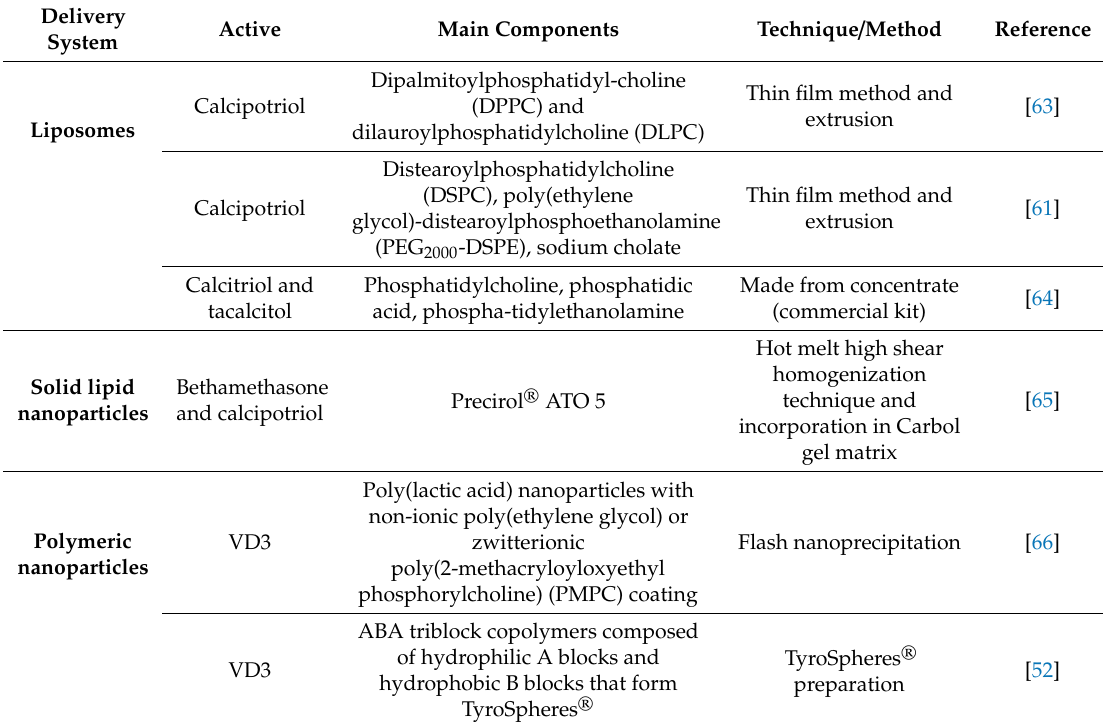
Table 2. Examples of various types of delivery systems reported for encapsulation of vitamin D or its analogues for potential topical delivery (VD3—vitamin